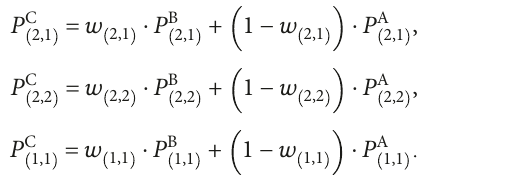
Figure 9: Comparisons of probability indexes of E native information, dotted curve), attached probability (using only induced information, dashed curve), and combined probability (using all available information, solid